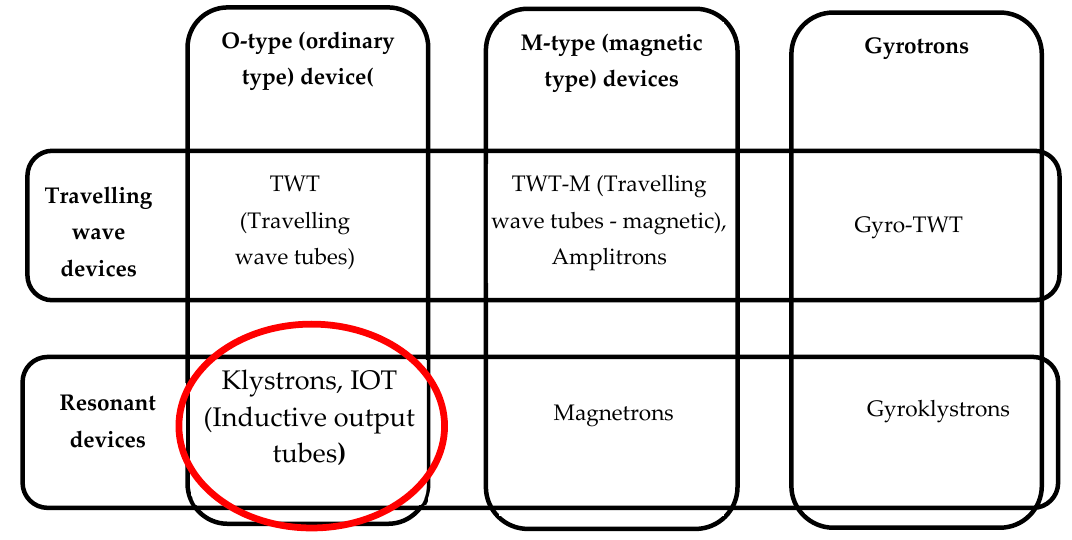
Figure 1. Classification of high-power vacuum electronic devices.